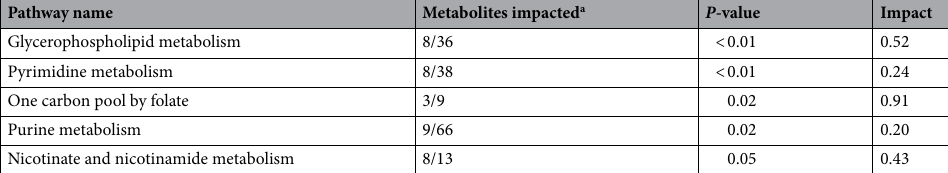
Table 3. Significantly impacted pathways by Aloe supplementation (AL; 10 g/d of lyophilized A. arborescens Mill. from ‒ 7 to 7 days from dry-off [DFD]) compared with control diet (CTR) in dairy cows at 7 DFD. a Number of metabolites impacted by Aloe supplementation out of the total number of metabolites in the considered